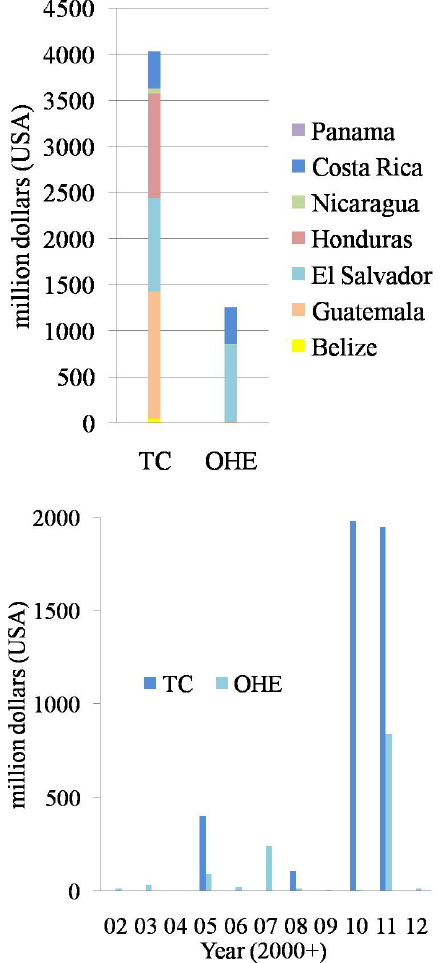
Fig. 3. (a) Loses in millions of $USA per country in Central America due to tropical cyclone activity (TC) and other hydro- meteorological events (OHE) and, (b) total loses in millions of $USA per year in Central America due to TC and OHE during 2002–2012. Dollar amounts are for the years in which the event was recorded, so quantities are not corrected by